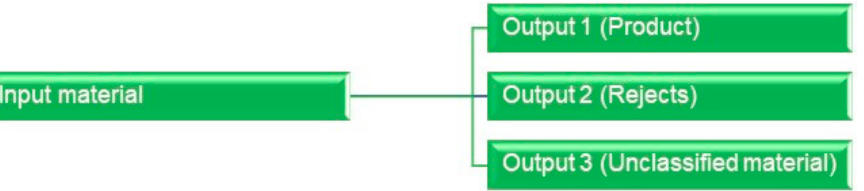
Figure 7. Classification of the input material to the HSI-based sorting system into three output streams. The distribution of the input material among the three output fractions was deter- mined and the components of the product (output 1) and rejects (output 2) were quanti- fied. The overall plasterboard recovery yield was calculated using Equation (4).